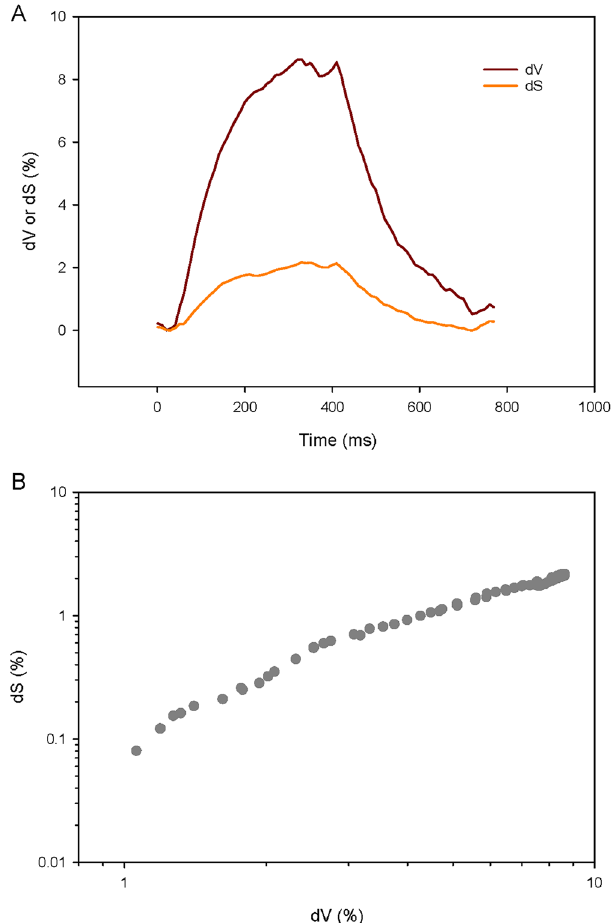
Figure 4. ( A ) Relative surface and volume change of peripheral airspaces within a sample ROI (green circle in Fig. 3A excluding the bronchus); ( B ) Log–Log relation between changes in surface (S) and volume (V). A fit of this relationship by linear regression yields the exponent n and a constant k in S = kV n .